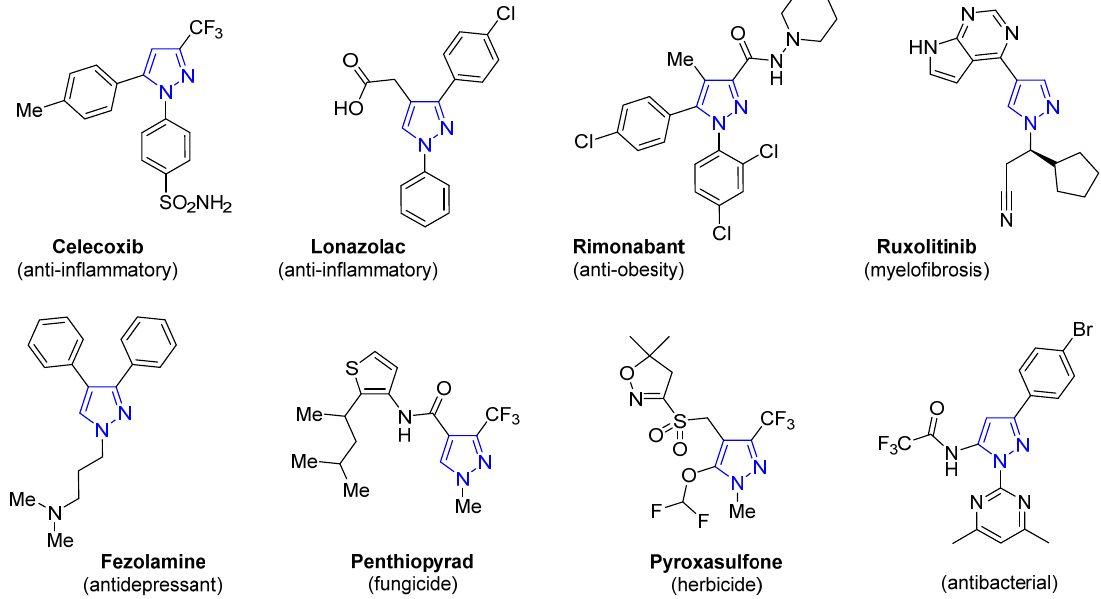
Figure 1. Structures of selected fluorinated and non-fluorinated pyrazole-based pharmaceuticals and agrochemicals.